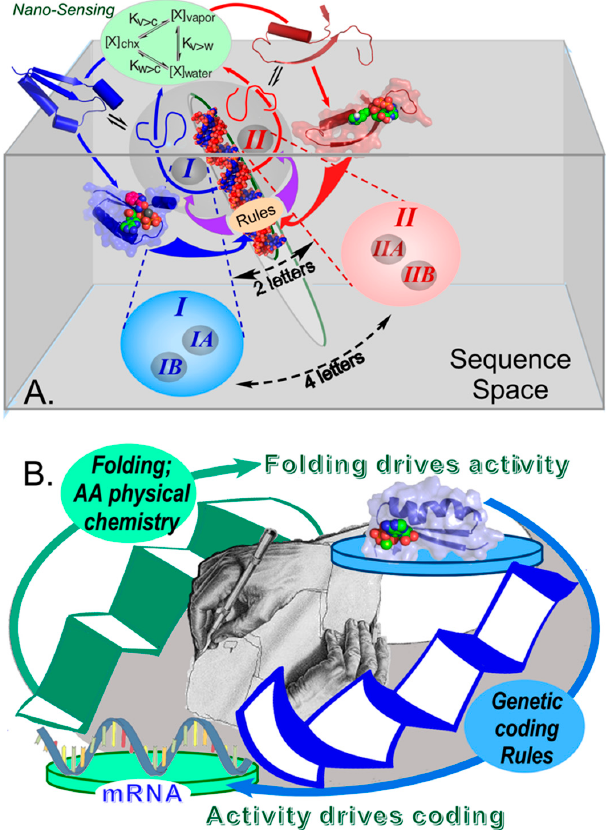
Figure 3. Reciprocally-coupled gating in the origin of genetic coding. ( A ). A single bidirectional gene encoding ancestral genes for Class I (blue) and Class II (red) aaRS on opposite strands combines with nanosensing arising from the equilibrium distributions of amino acid side chains between vapor, water, and cyclohexane [8–10,78–81] provide a boot-block for installing biology’s operating system by furnishing the minimal instruction set necessary to launch coded peptide-bond formation [11,12] based on two distinct amino acid types (adapted from [101]). ( B ). The underlying process control structure of that boot-block. Sequences are active if and only if they fold; and active sequences fold if and only if they obey the relevant coded sequence, which the aaRS collectively themselves enforce. The central graphic is adapted from M. C. Escher (adapted from